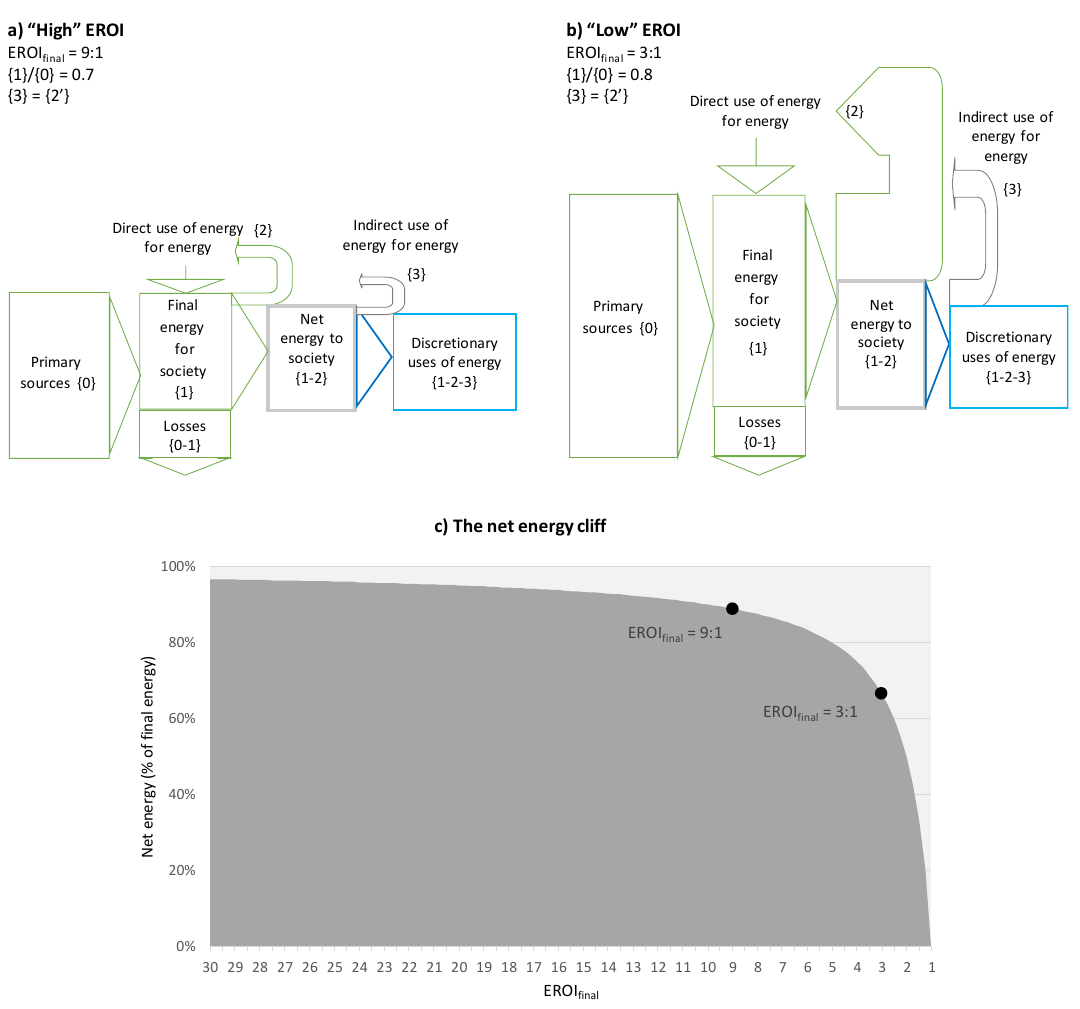
Figure 2. A comparison between two hypothetical societies with the same energy flow available for discretionary uses {1-2′-3} (blue box) but with different EROI final and relative losses ({0-1}/{1}). The size of vertical arrows is at scale. ( a ) EROI final = 9:1, {1}/{0} = 0.7, assuming indirect energy use equal to direct one (see Section 3); ( b ) EROI final = 3:1, {1}/{0} = 0.8, indirect energy used equal to direct one ({2′} = {3}); ( c ) shows the resulting share of net power vs. gross power in the net energy cliff.